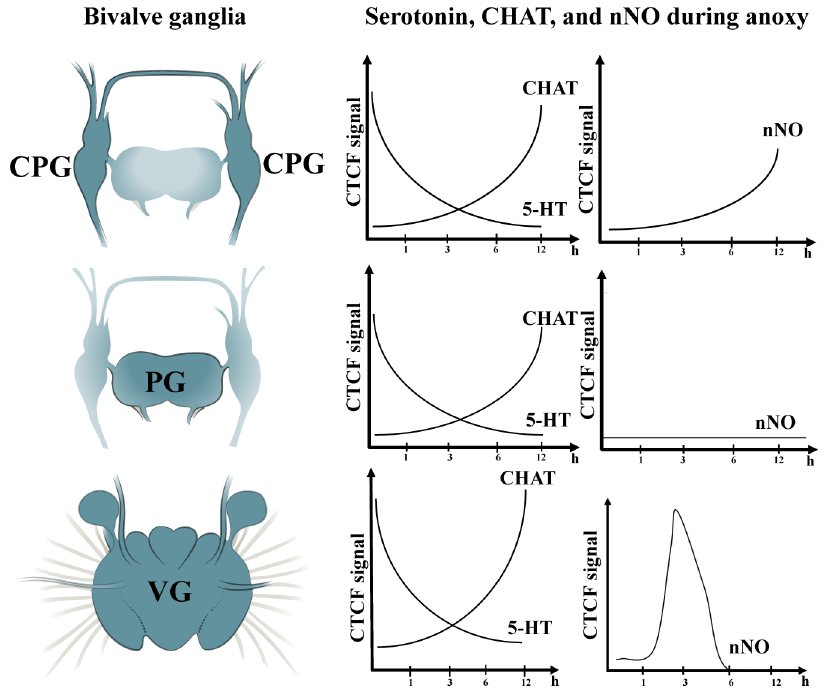
Figure 3. Temporary changes indistribution of neurotransmitters in scallop ganglia during air exposure-induced hypoxia. ( Left ) Quantitative representation of neurotransmitters. ( Right ) Varia- tions in5-HT, CHAT, and uNOS in cerebropleural ganglia (CPG), pedal ganglia (PG), and visceral ganglia (VG) during hypoxia exposure (at 0 (normoxia), 1, 3, 6, and 12 h).